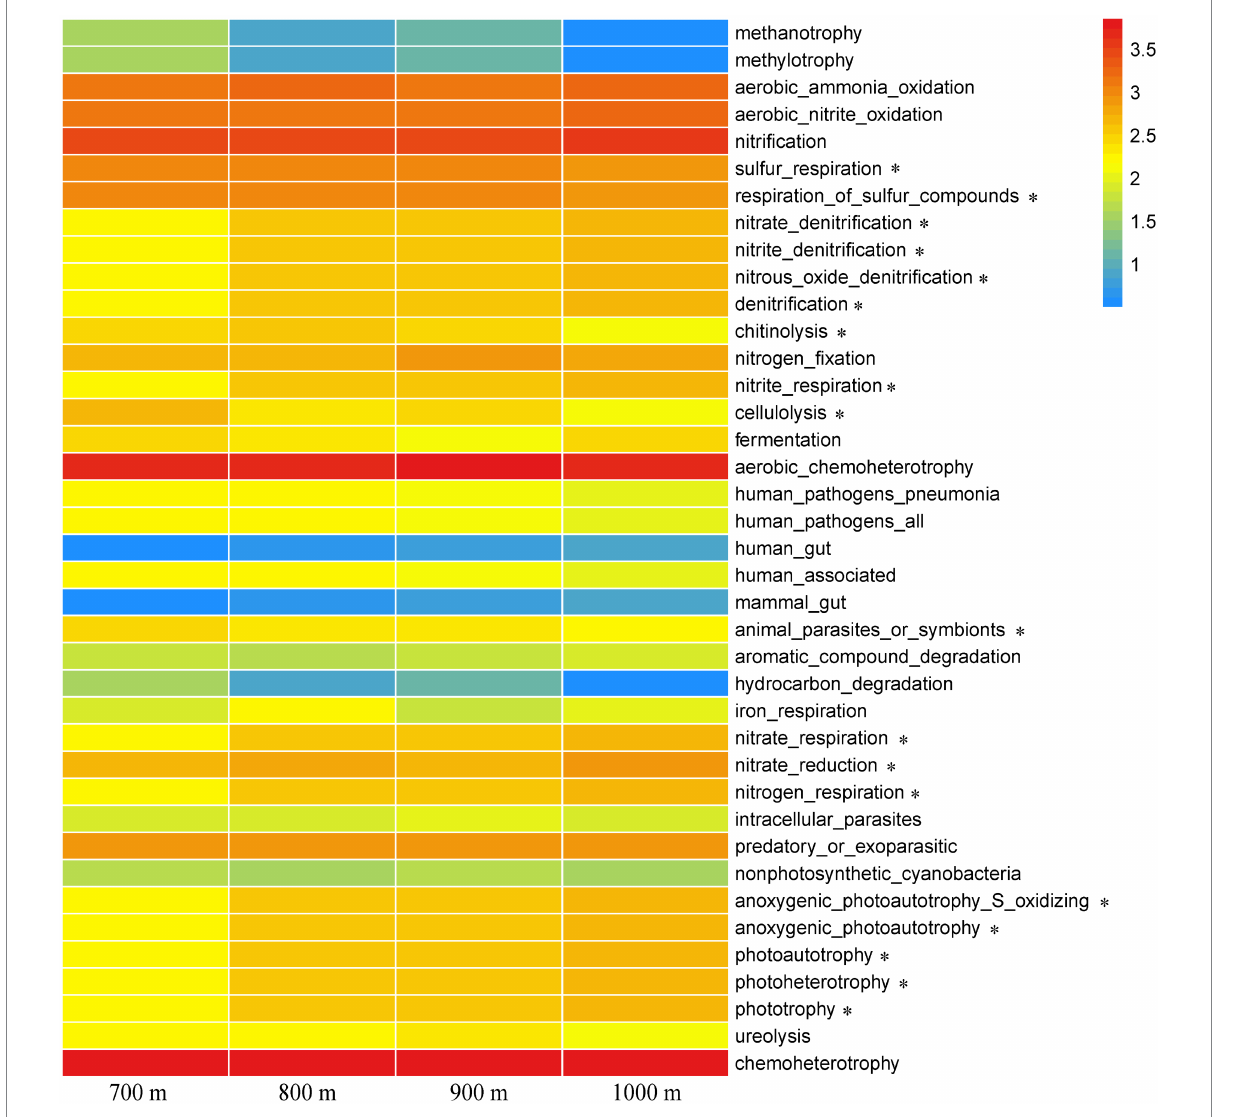
FIGURE 5 Heatmap of functional processes inferred from the relative abundance of the soil bacteria at the five different elevations. The color gradient (red, yellow, and blue) represents the relative abundance of the inferred bacterial functions from high to low. * indicated difference at the 0.05 level based on one-way